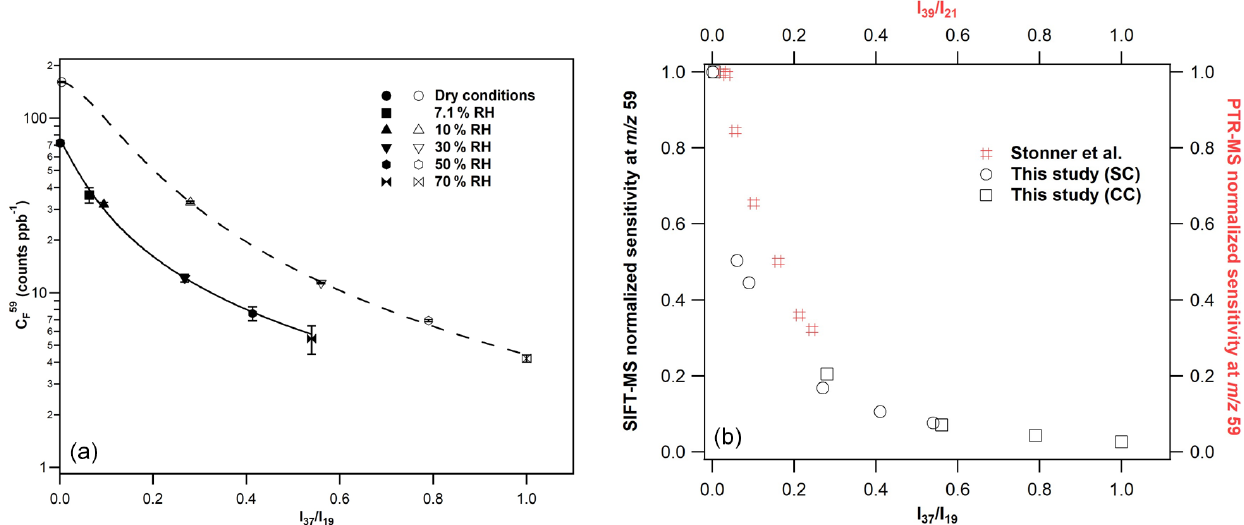
Figure 5. (a) Calibration factors of GL at m/z 59, derived from the H 3 O + precursor ion under SC (filled symbols) and CC (open symbols) conditions. The errors quoted correspond to the 2 σ precision of the fit to obtain the calibration factors. The lines are the fitting of calibration = 2.99, b = 0.04, and c = 1.20 and CCs ( counts per ppb ) = a factors with the following empirical expression: C 59 (cid:16) I (cid:17) c , where, for SCs a F 37 b + I 19 a = 4.53, b = 0.03, and c = 1.74. (b) GL normalized sensitivity at the mass peak of 59 of SIFT-MS (in black) and PTR-MS (in red) versus the I 37 /I 19 and I 39 /I 21 ratios. For SIFT-MS, the reduction in instrument sensitivity is similar for both SC and CC conditions. For comparison purposes, the data presented in Fig. 5 of Stönner et al. (2017) study were extracted and displayed in the graph. A steeper decrease in GL sensitivity is noticed with SIFT-MS at lower levels of humidity than